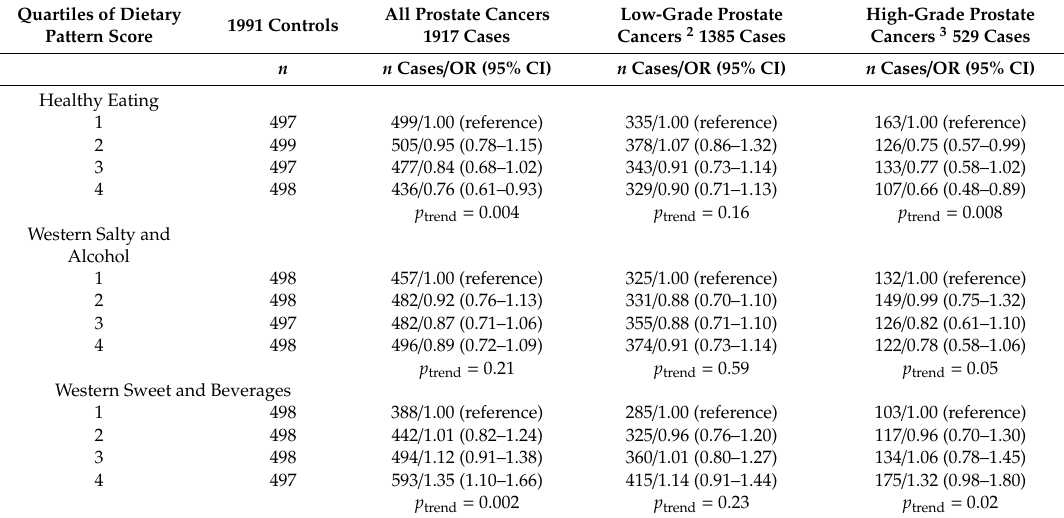
Table 3. Odds ratios (OR) and 95% confidence intervals (CI) for the association between dietary pattern scores and prostate cancer risk, overall and by tumor grade, PROtEuS, Montreal, Canada, 2005–2012 1 . Quartiles of Dietary Pattern